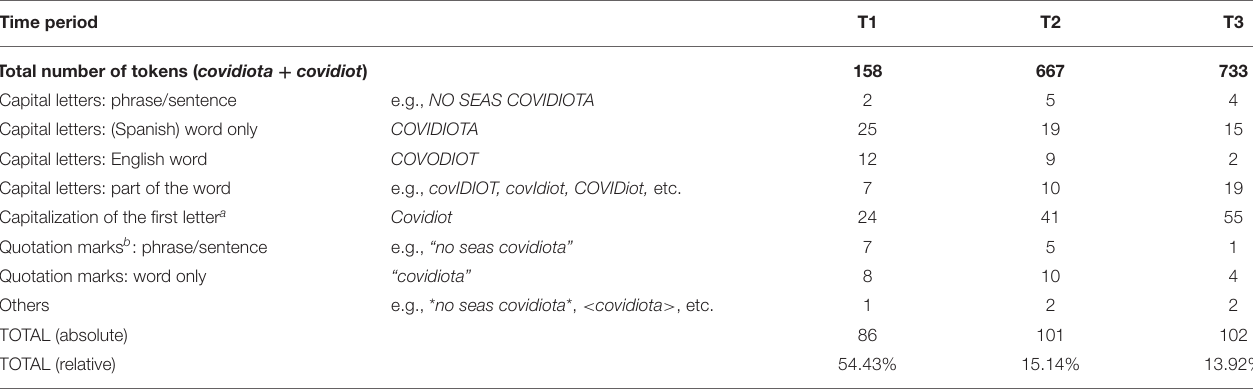
TABLE 2 | Results for graphical highlighting.